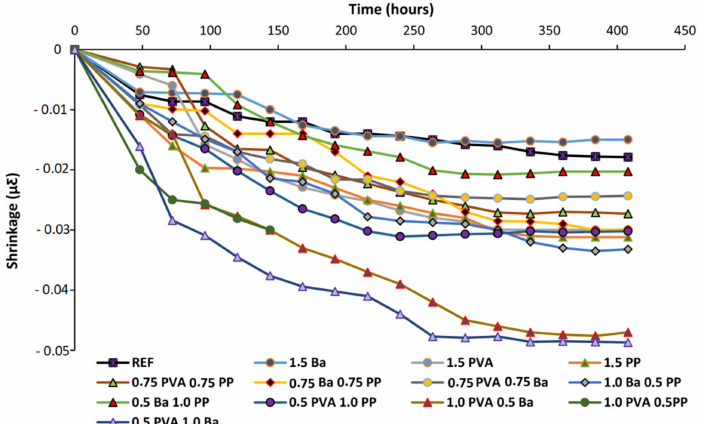
Figure 8. The effects of using different fiber types and combinations on the drying shrinkage. Adapted with permission from [65], copyright 2020